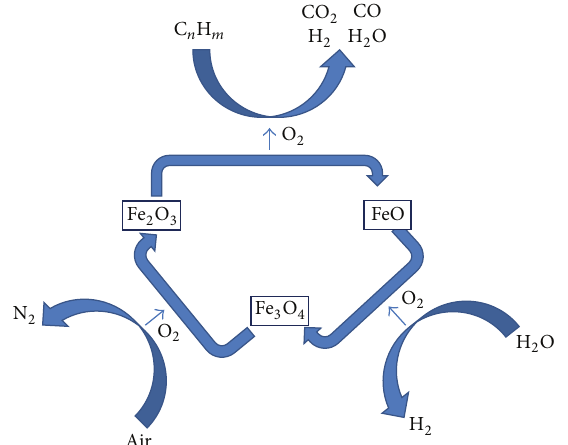
Figure 1: The concept of hydrogen-rich gas production supported by chemical looping process.